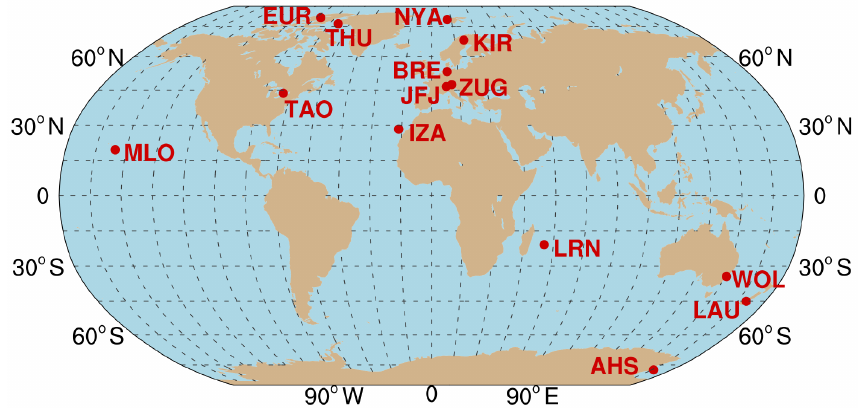
Figure 1. Location of the 14 NDACC ground-based remote-sensing FTS sites used in this study. The three-letter acronyms correspond to the information in Table